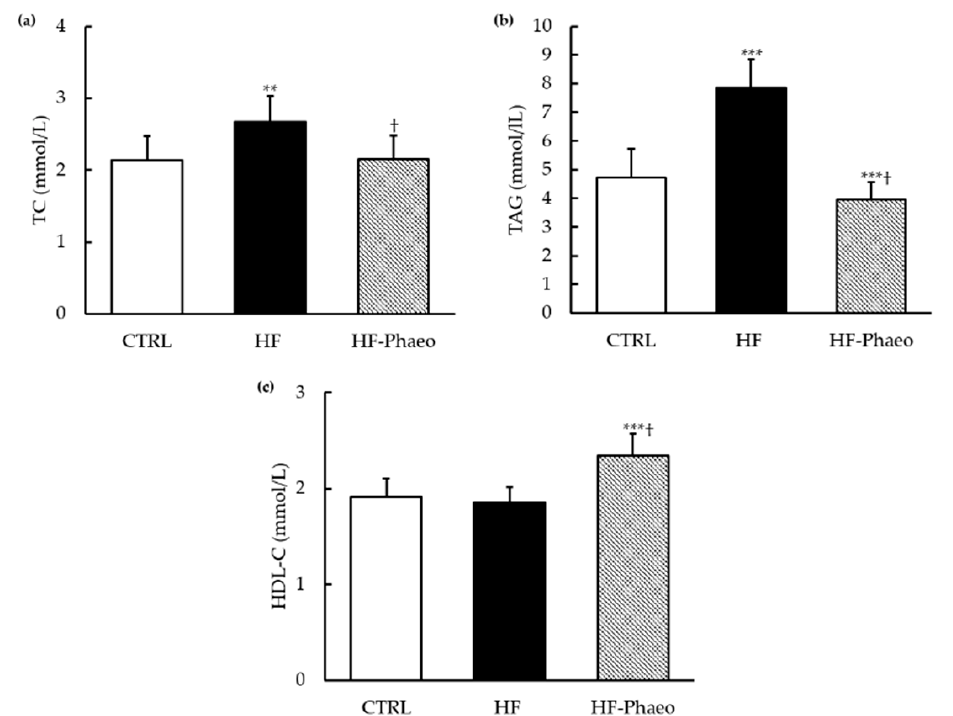
Figure 1. TC ( a ), TAG ( b ) and HDL-C ( c ) of the control animals, HF animals and HF animals that received P. tricornutum . CTRL, control group; HF, high-fat group; HF-Phaeo, high-fat group supplemented with P. tricornutum ; HDL-C, high-density lipoprotein; TC, total cholesterol; TAG, triacylglycerol. Values are means ( n = 6), with standard deviations represented by vertical bars. Mean values were significantly di ff erent from those of the CTRL group: ** p < 0.001; *** p < 0.0001 (one-way ANOVA; LSD post hoc test). † Significant di ff erence compared with the HF group ( p <